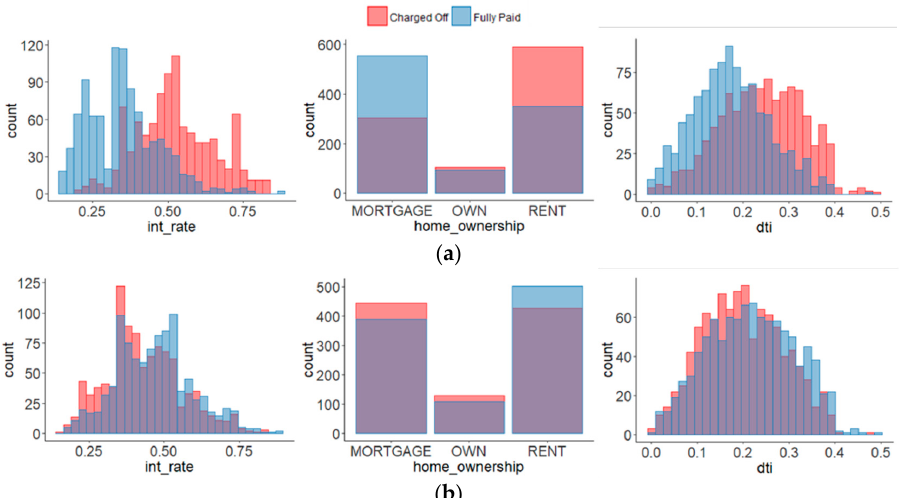
Figure 5. Comparison of distribution of classified samples. ( a ) Distribution of well-classified samples. ( b ) Distribution of misclassified samples.